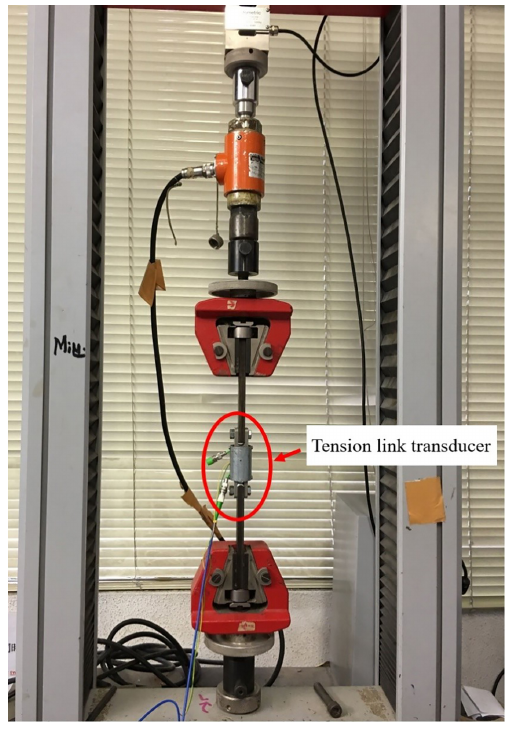
Figure 2. Calibration of a tension link transducer.